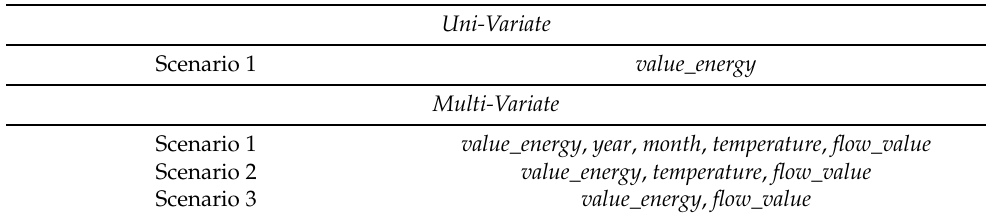
Table 5. Uni- and multi-variate data scenarios.